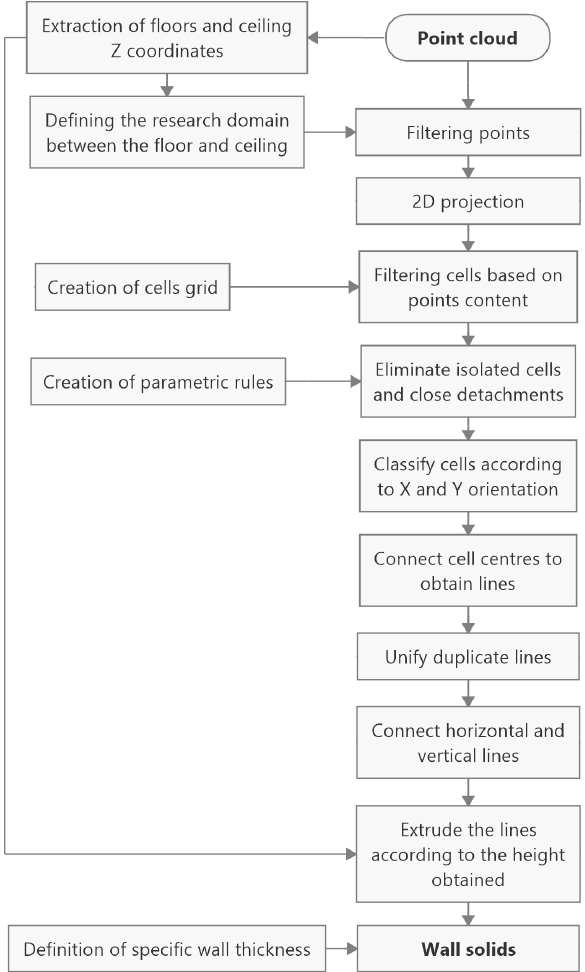
Figure 2 . Overall process of the proposed